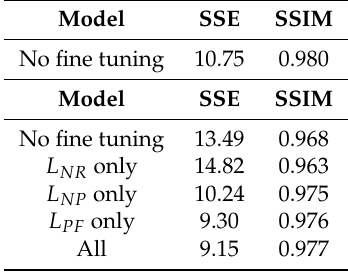
Figure 12. Future-frame prediction result after receiving two initial frames for FTB. ( top ) The model predicted results (PRED) and ground-truth (GT) for FTB-synthetic. ( bottom ) Results of the model trained only with FTB-synthetic on FTB-real (w/o fine-tuning), results after fine-tuning with FTB-real (w/ fine-tuning), ground-truth with background subtracted (BS), and ground-truth. In Diff, the green area represents the correct part, and the red area represents the wrong part of the model’s prediction. Table 6. Quantitative results of experiments on FTB. (top) Test results for FTB synthetic after training model with FTB synthetic. (bottom) Test results for FTB real depending on the fine-tuning